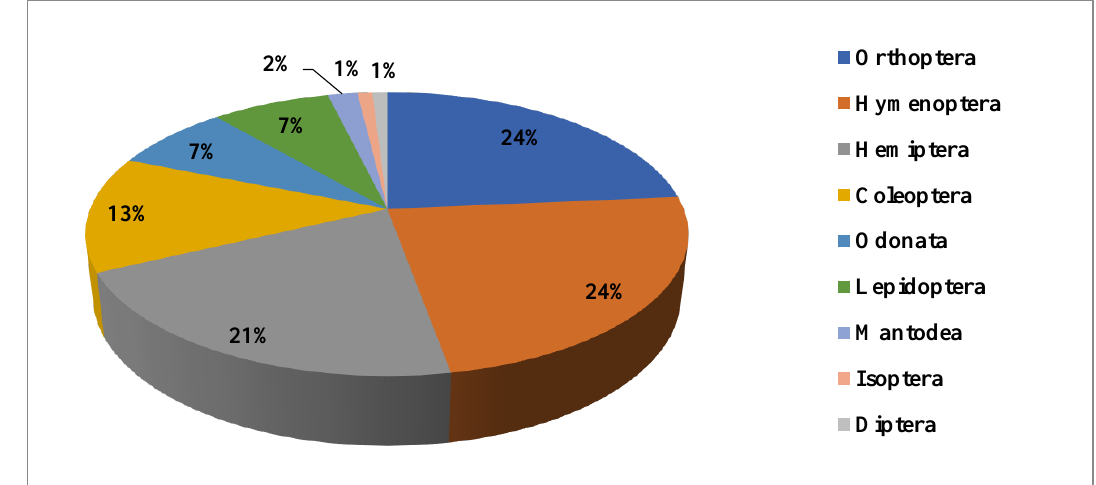
Figure 2. Percentage contribution of edible insects by each insect order.